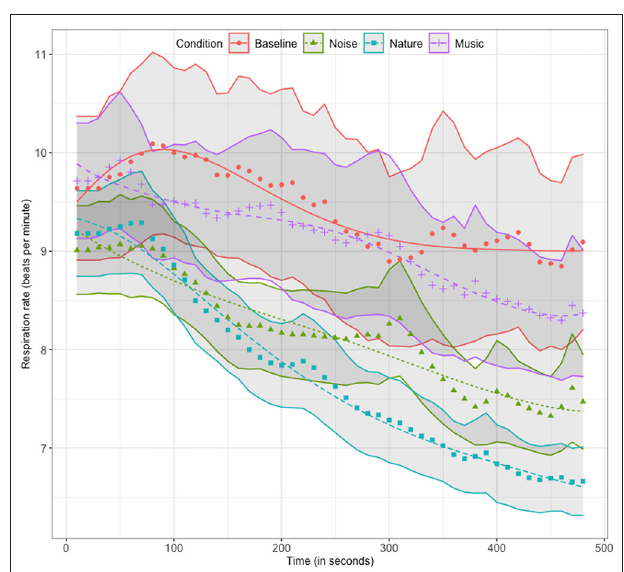
“cognitive stress” component [ F (3, 298) = 4.307, p = 0.006, η 2 =